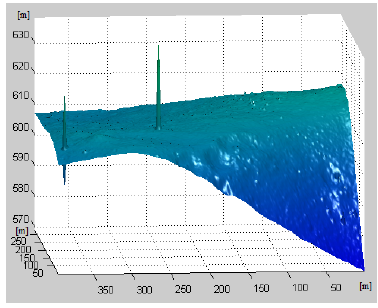
Figure 4. Sharp protrusions caused by measurement noise in the LiDAR data